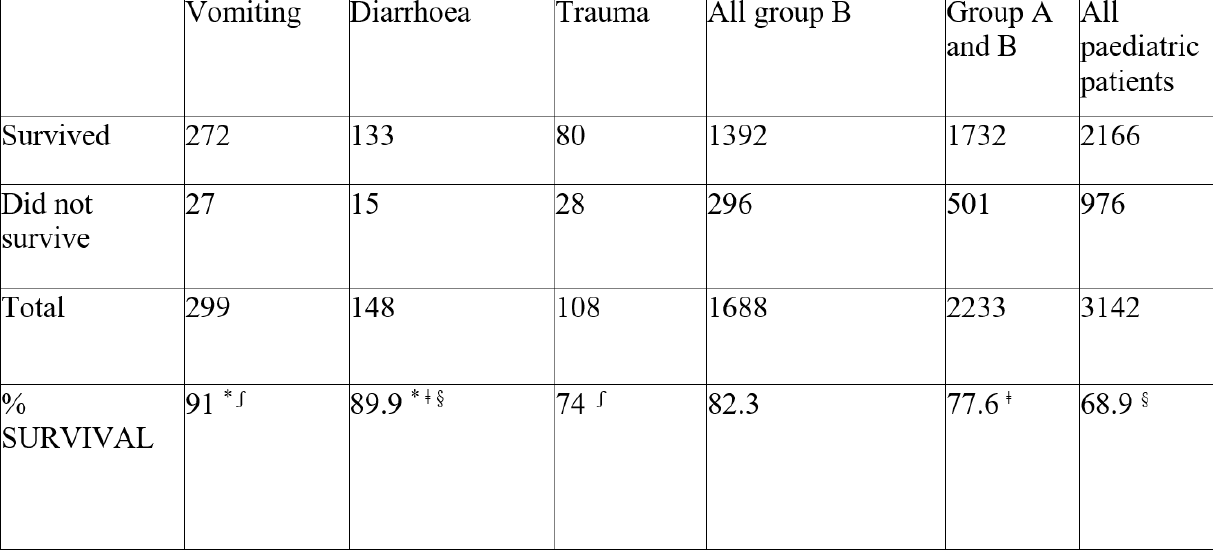
Table 3: Outcome recorded for the three most common presentations for canine patients 3-6 months old who attended the clinic and followed veterinary advice. Categories indicated by matching symbols ( * ǂ § ʃ ¢) indicate pairs where survival was significantly